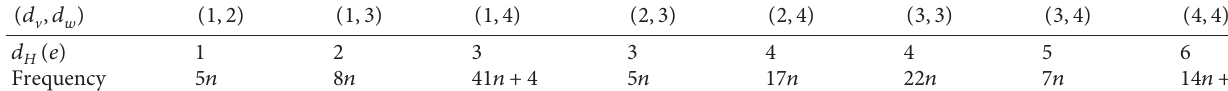
Table 3: Partition of an edge and the degrees of